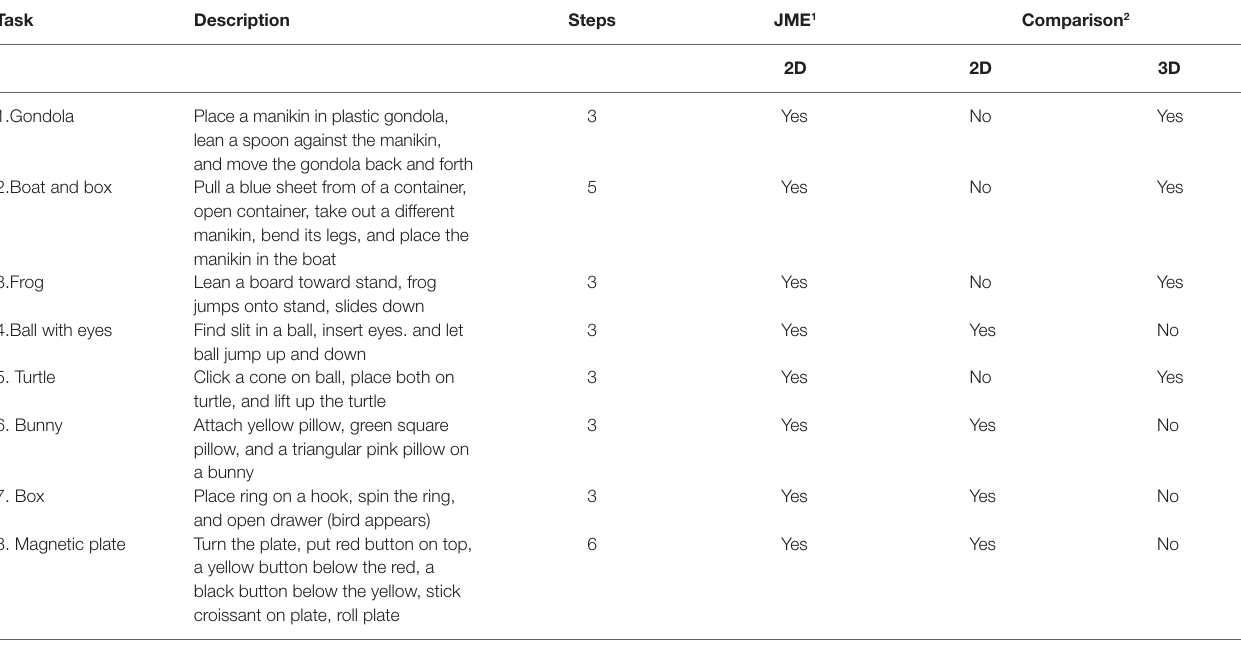
TABLE 1 | Description of the tasks in the Frankfurt Imitation Test (FIT) and their inclusiveness in the different groups [adapted from Kolling and Knopf, (2015, pp. 366–368)]. Task Description Steps JME 1